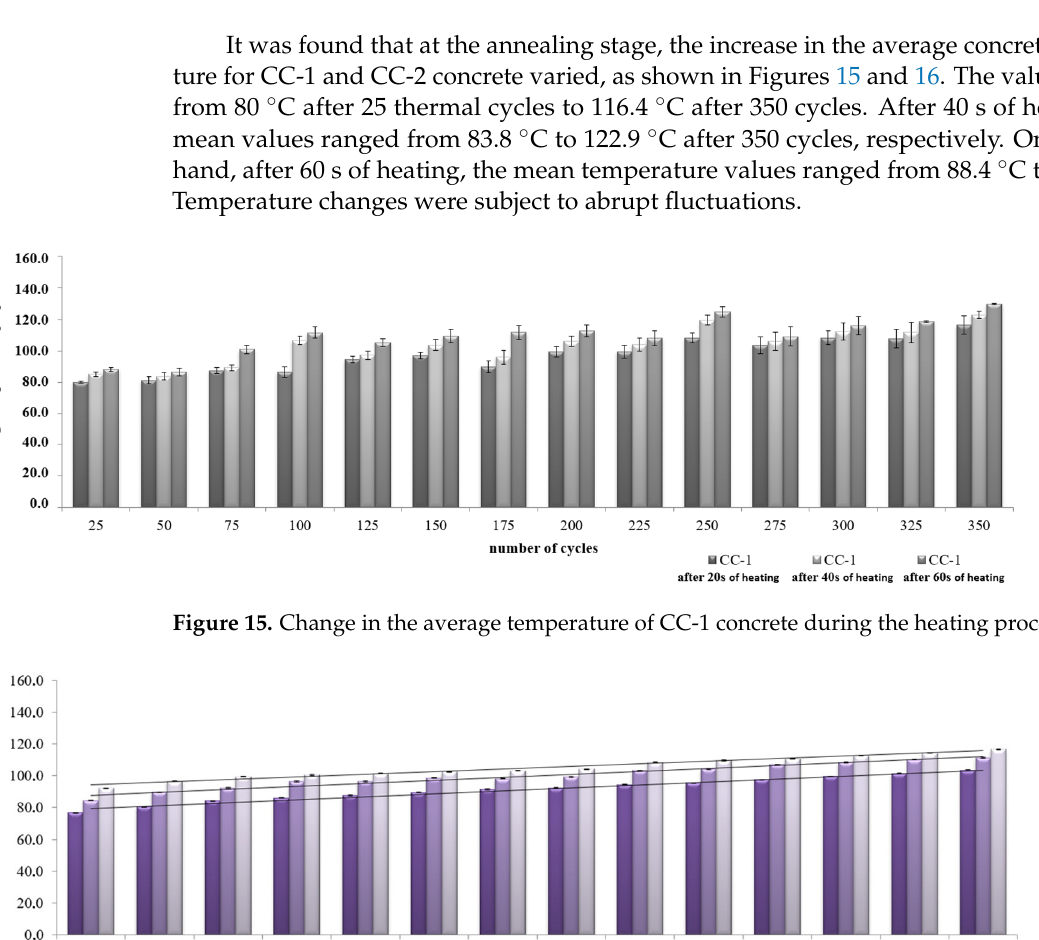
Figure 16. Change in the average temperature of CC-2 concrete during the heating